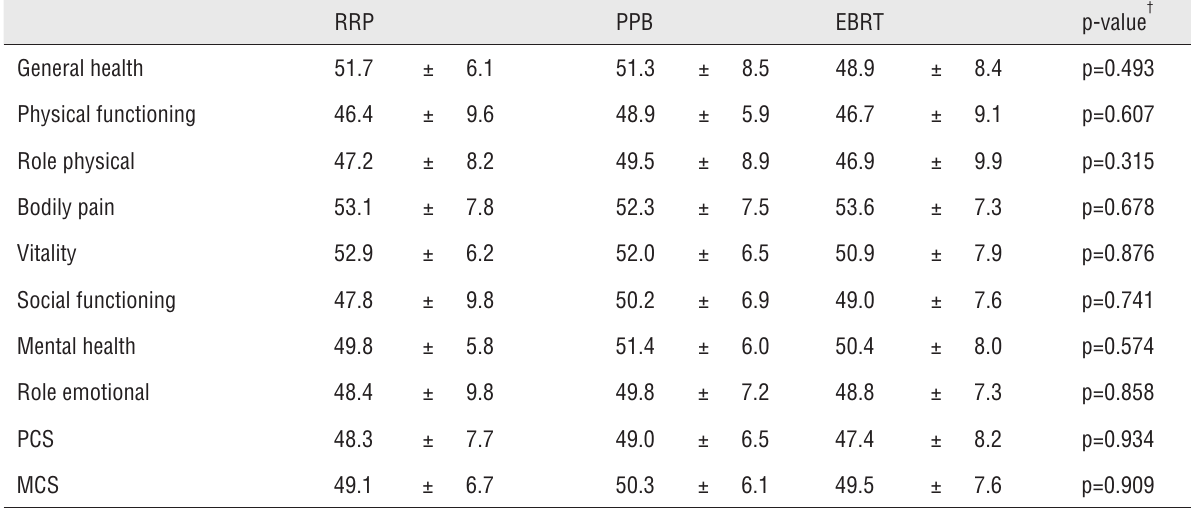
Table 2 - Subscales and component summaries of Sf-8 in 3 treatment